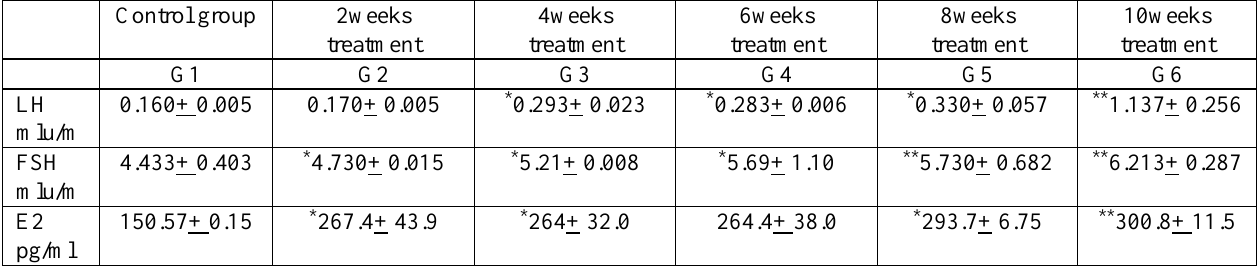
Table (8): Hormonal changes after oral administration of 16 mg / daily of Pentoxifylline to mature female